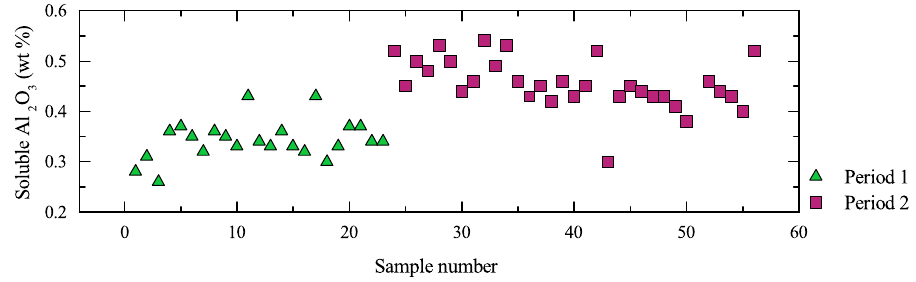
Figure 2. Soluble Al 2 O 3 content of the calcined kaolin samples from the two periods. The numbering of the samples refers to the collection chronology (error bars are smaller than plot symbols).